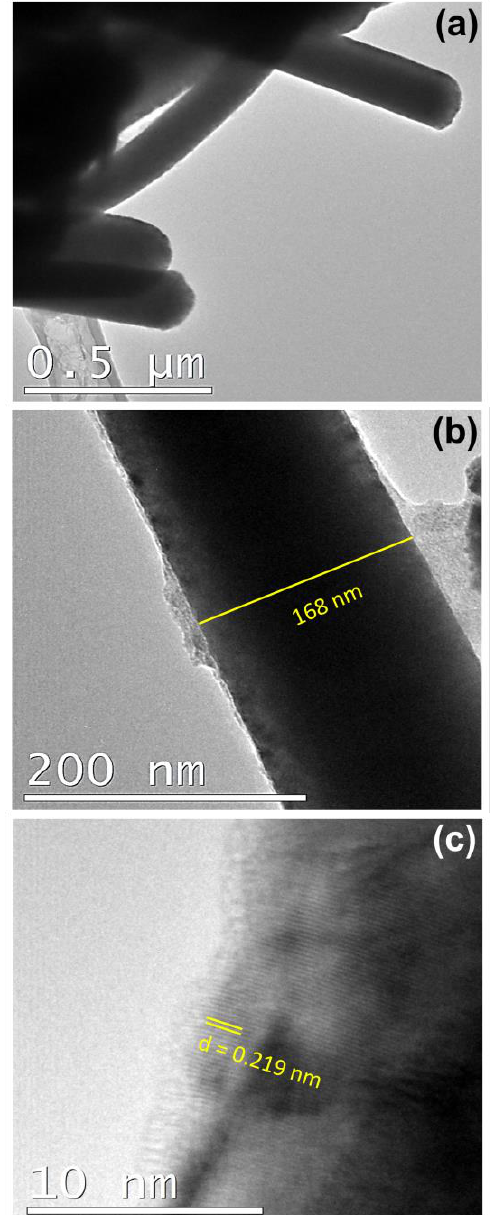
Figure 7. Bright-field TEM images of Porous-A NWs: ( a ) A bunch of NWs, ( b ) diameter of a single NW and ( c ) close-up view of the wall.